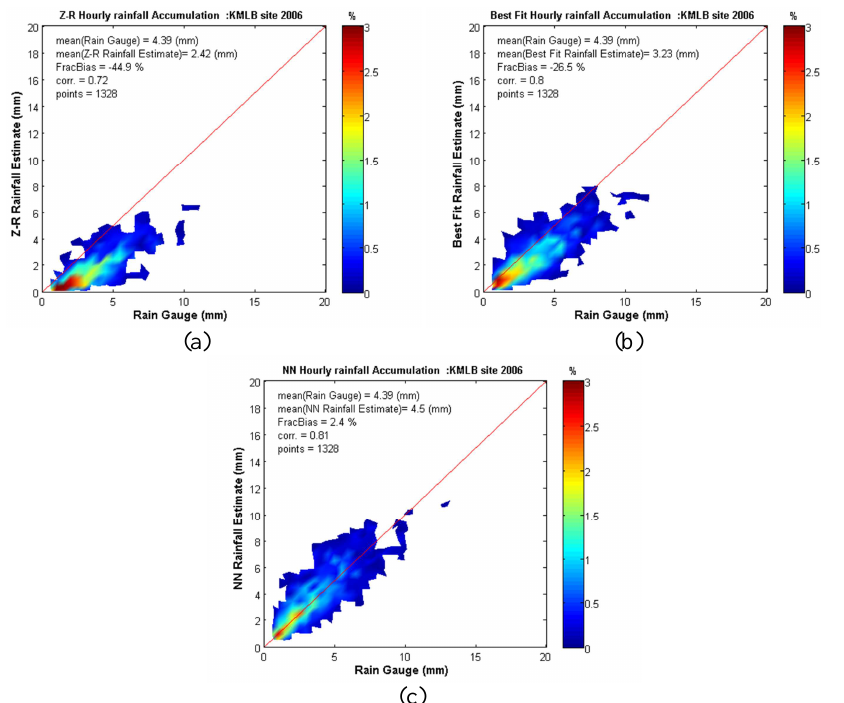
Fig. 6. Actual rain gauge vs. (a) Z – R estimate, (b) best-fit estimate and (c) NN estimate. Data from year 2006 over KMLB. (Hourly rainfall accumulation).